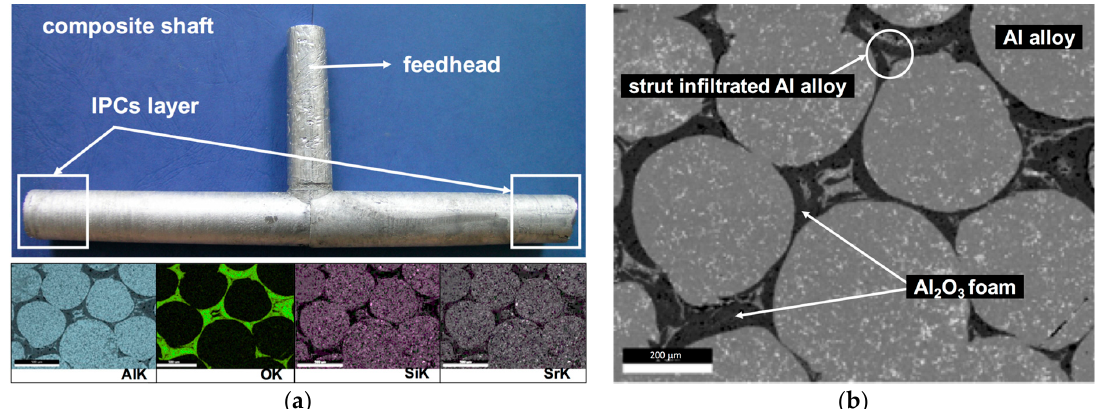
Figure 3. The AlSi12/Al 2 O 3 _2 composite cast obtained by centrifugal infiltration: ( a ) view of the representative centrifugal cast in the form of locally reinforced shaft, and X-ray mapping of Al, O, Si and Sr in area of reinforcement; ( b ) SEM image of interpenetrating composites (IPCs) layer. Tribological studies (wear resistance, coefficient of friction) were carried out in cross-sections of the composite layer formed by the centrifugal infiltration process and compared with the unreinforced area. The samples used to determine the tribological properties (Table 1), sized 30 × 15